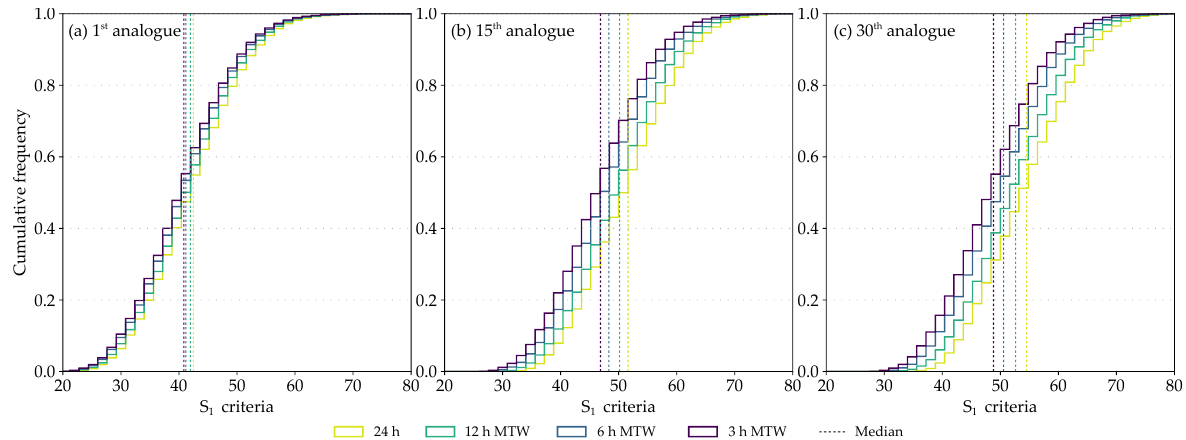
Figure 3. Changes in S 1 criterion distributions due to the introduction of an MTW with a 12, 6, or 3h time step. Distributions are provided for (a) the 1st, (b) 15th, and (c) 30th analogue ranks for all days of the CP at the Ulrichen station.